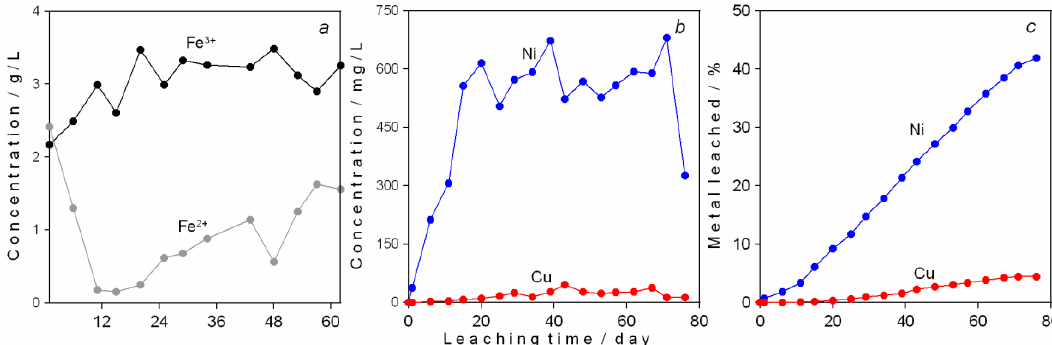
Figure 5. Ferrous and ferric ion concentrations ( a ), non-ferrous metal concentrations in the leach solutions ( b ), and their extraction ( c ).